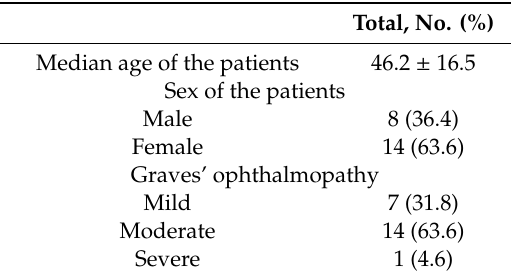
Table 2. Characteristics of patients ( n =